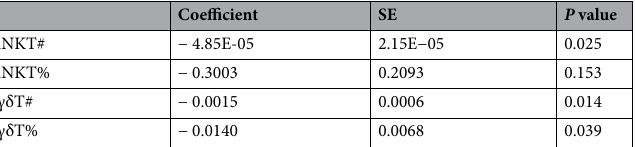
Table 3. Correlation of peripheral blood iNKT and γδT cells with acute cerebral infarction in patients. % percentage, # cell count, SE standard error.